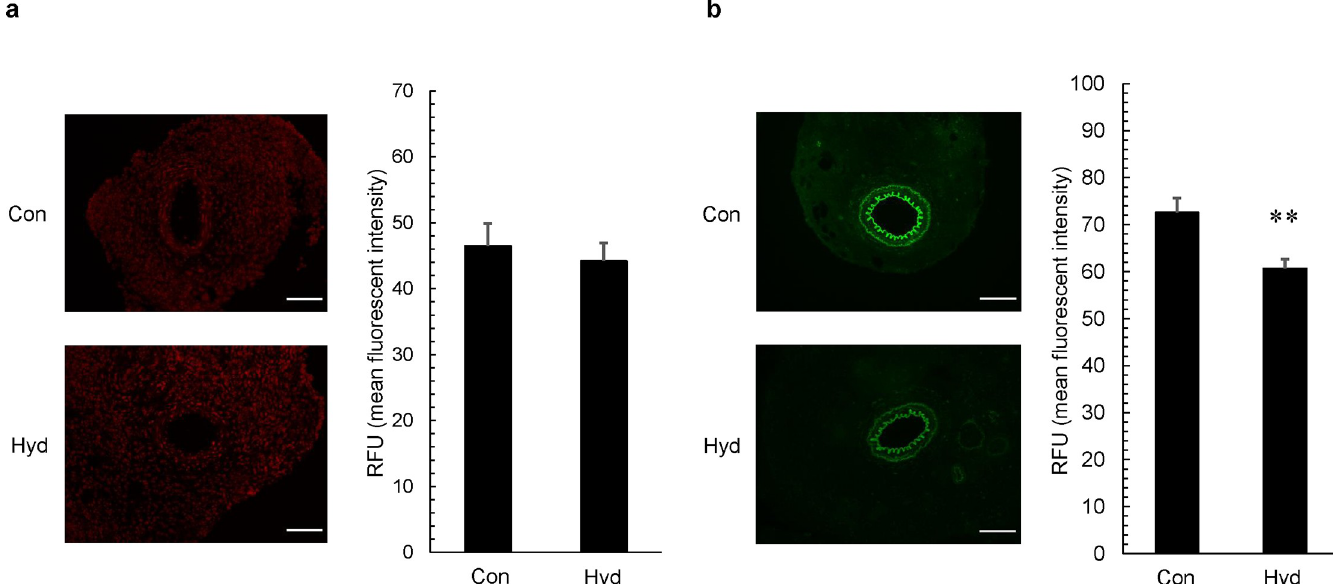
Fig 5. Effect of hydrogen gas inhalation on ROS production. Tissue samples were prepared from cuffed arteries 7 days after operation. (A) Representative photos of cross-sections of injured femoral artery after DHE staining and fluorescence intensity in intima and media. (B) Representative photos of cross-sections of injured femoral artery after HPF staining and fluorescence intensity in intima and media. The original photos were obtained as 8-bit images (original magnification × 200; scale bar: 100 μ m), and data represent relative fluorescence units (RFU). Values are mean ± SEM (n = 18 to 21 for each group). �� p < 0.01 vs. air group (Con). Hyd; hydrogen group.